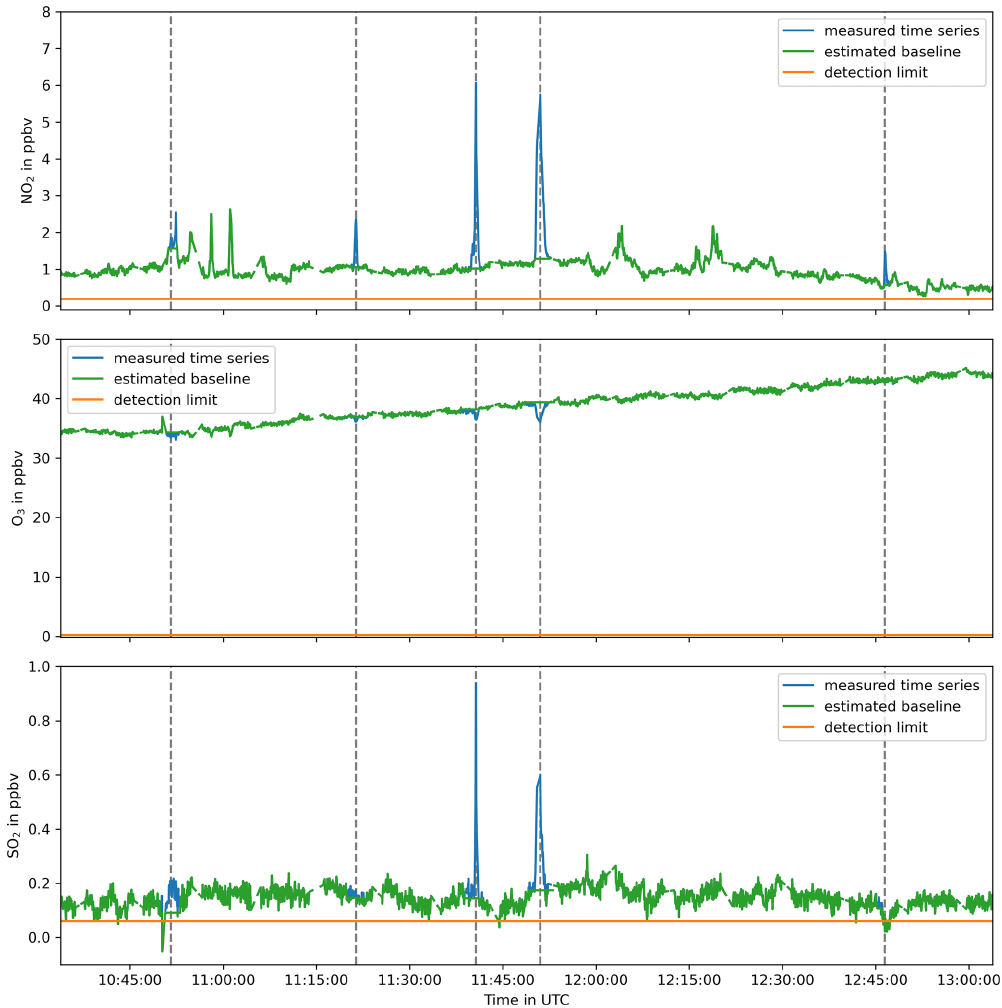
Figure 2. Example time series of the fitted trace gases from 19 August 2018 between 10:30 and 13:00UTC. In each plot the blue line shows the fitted time series of the respective trace gas, and the orange line shows the respective median detection limit. The grey dashed lines mark passing ships that have been assigned to a peak in the time series. The green line shows the calculated